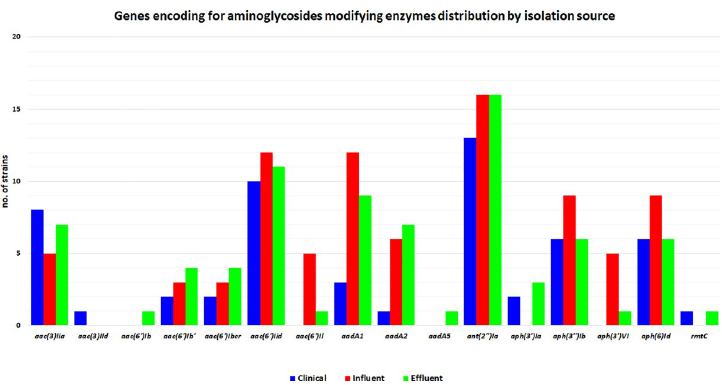
Fig 2. AME genes identified in the K . pneumoniae isolated from wastewater and clinical settings.